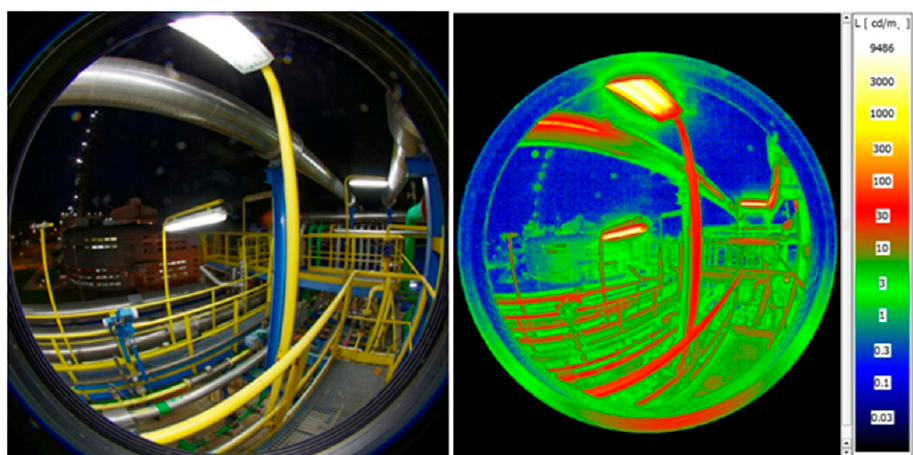
Figure 4. The view from the measurement point with corresponding luminance map. Measured GR = 53, subjective sensation of glare: just admissible, task of activity [5]: Filling and emptying of container trucks and wagons with dangerous substances, replacements of pump packing, general service work, reading of instruments, GR MAX from standard [5] = 45.